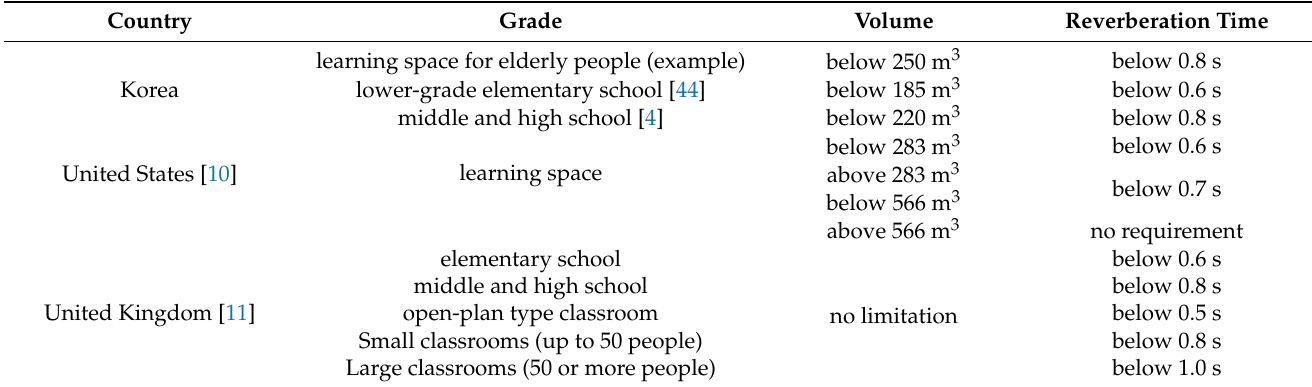
Table 15. Comparison of reverberation time standards in various countries